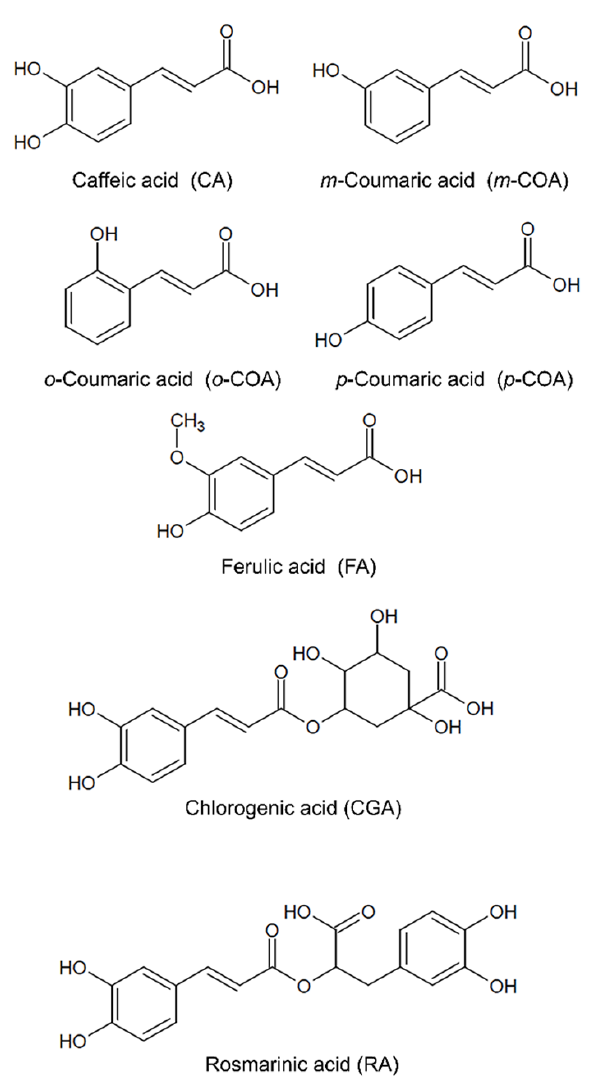
Figure 1. Chemical structure of hydroxycinnamic acids (HCAs).